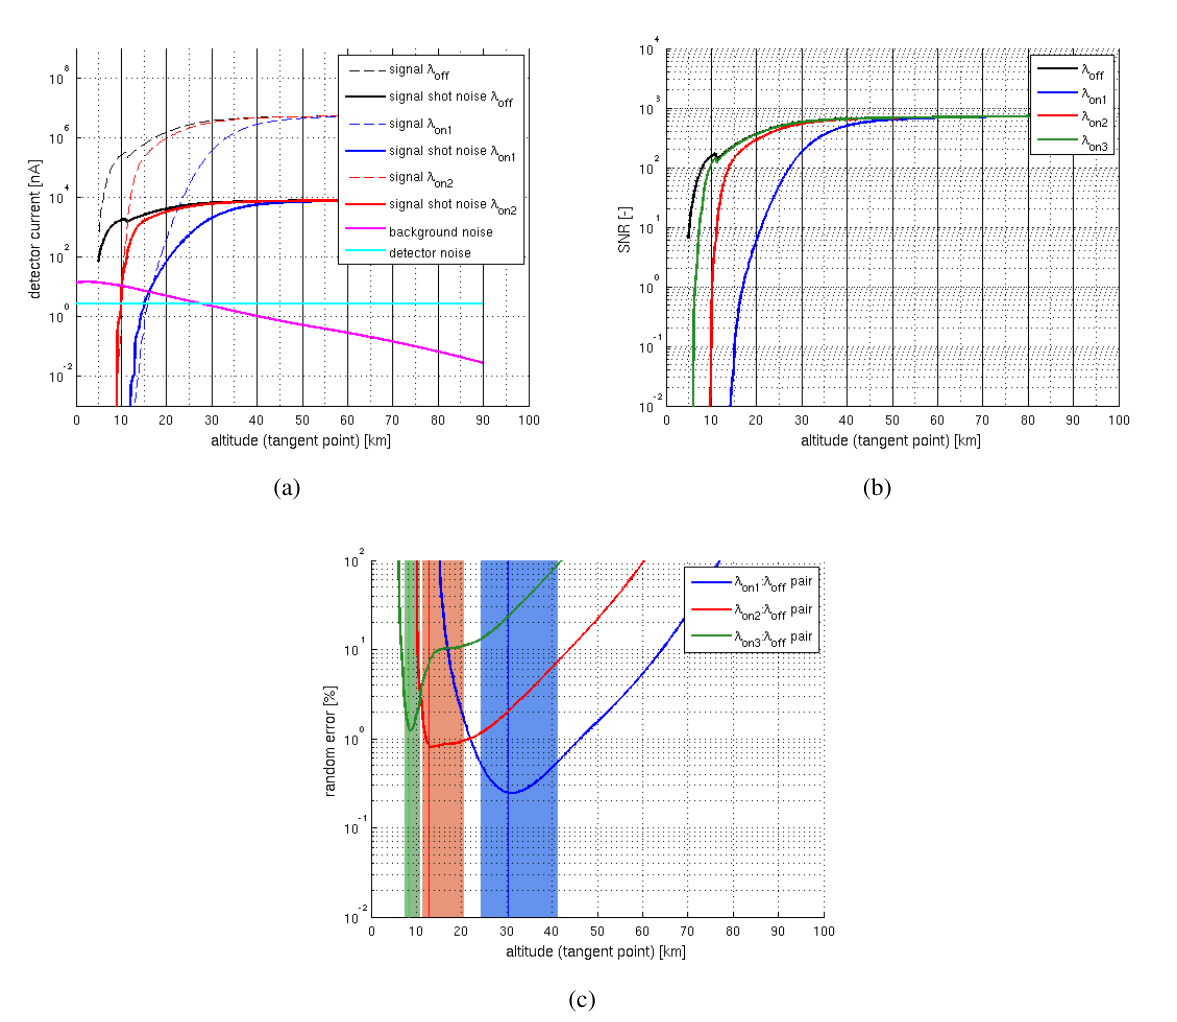
Figure 7. ( a ) Noise currents modelled for the IPDALLS receiving system. The offline wavelength and both the online wavelengths of highest relevance within the UTLS and with highest absorption coefficient have been chosen to illustrate the range of signal shot noise. ( b ) Signal-to-noise ratio (carrier-to-noise ratio) for the water vapour sounding wavelengths. ( c ) Relative random error of the water vapour two-way path-averaged optical depth for the various wavelength pairs. The coloured regions with the solid vertical lines correspond to the optimal measurement ranges (using geometric means) for each wavelength as defined in Figure